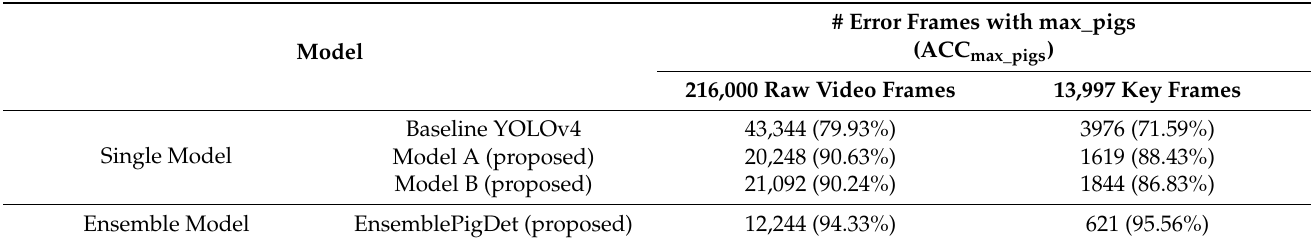
Table 3. Comparison of accuracy ACC max_pigs for 216,000 raw video frames and 13,997 key frames with overexposed regions (obtained during 8:30 a.m. to 10:30 a.m.).